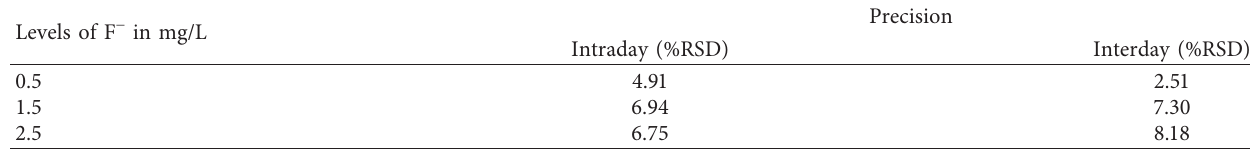
Table 1: Reproducibility and intraday and interday precisions during fluoride determination.